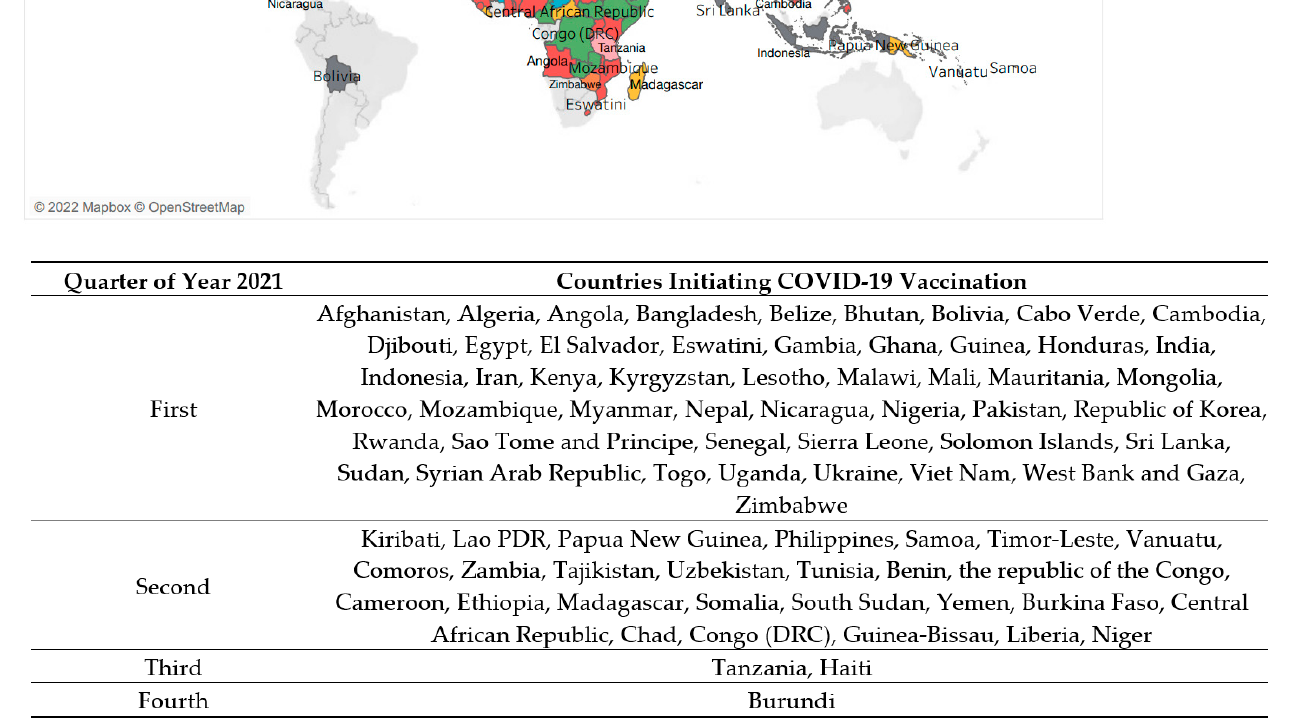
Figure 2. Period of Initiation of Vaccinations in LMIC and